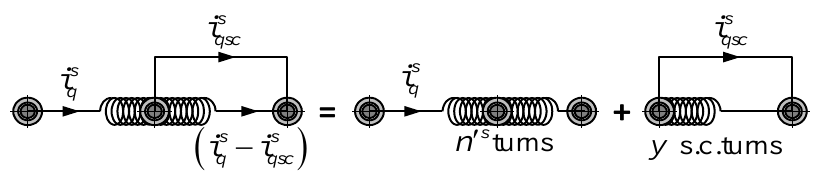
Figure 4. Proposed model for a faulty winding.